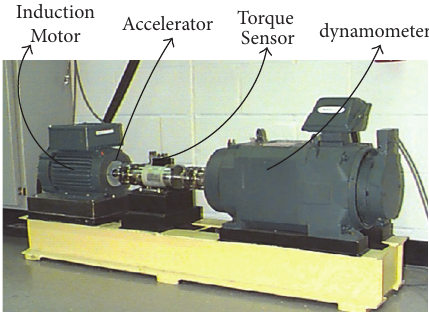
Figure 3: The test